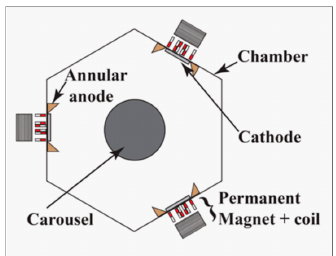
Figure 1. Top-view schematic representation (not to scale) of the deposition setup used.